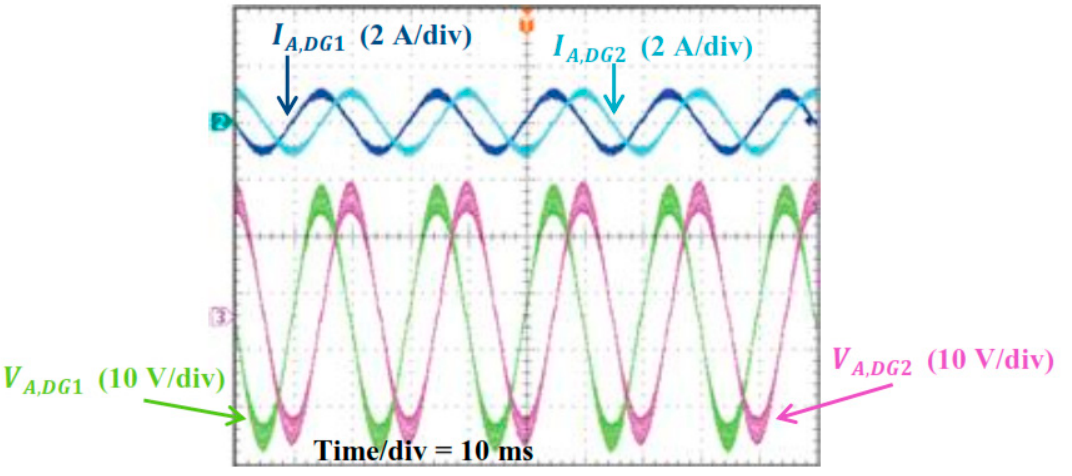
Figure 9. Experimental results of proposed controller: ( dark blue trace ) DG 1 output current, ( light blue trace ) DG 2 output current, ( green trace ) DG 1 output voltage, ( pink trace ) DG 2 output voltage.